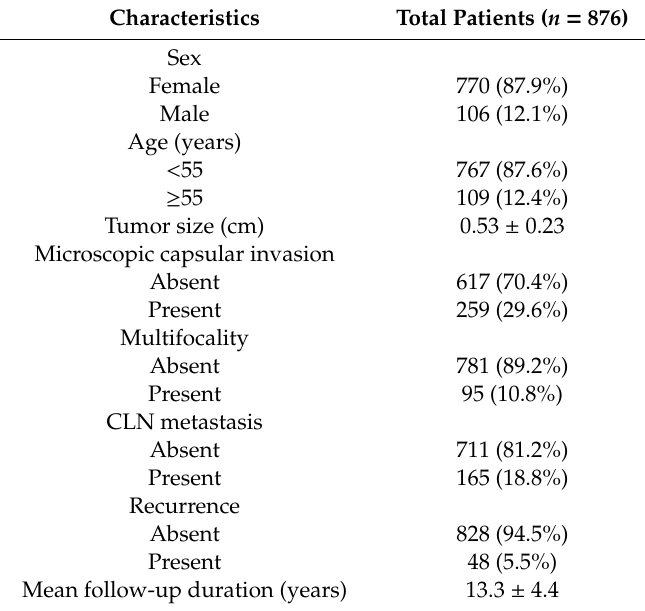
Table 6. Clinicopathologic characteristics of enrolled